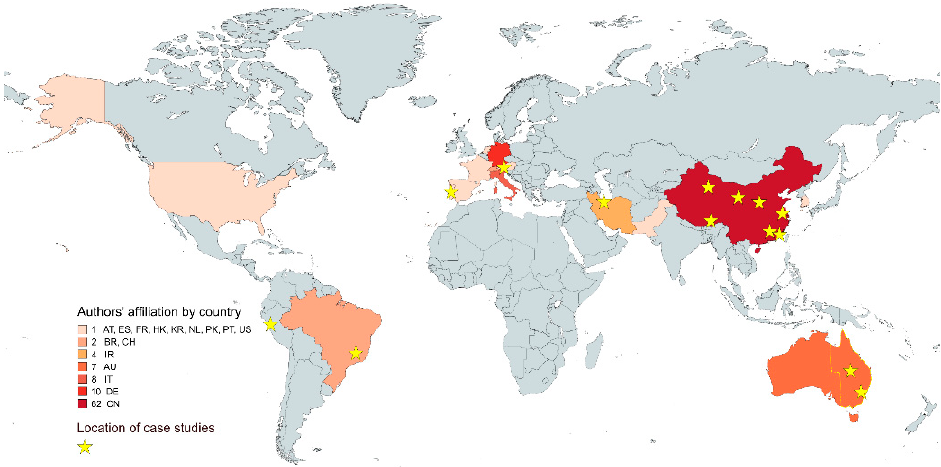
Figure 2. Overview of the authors’ affiliation by country together with the location of case studies discussed in the present Special Issue.